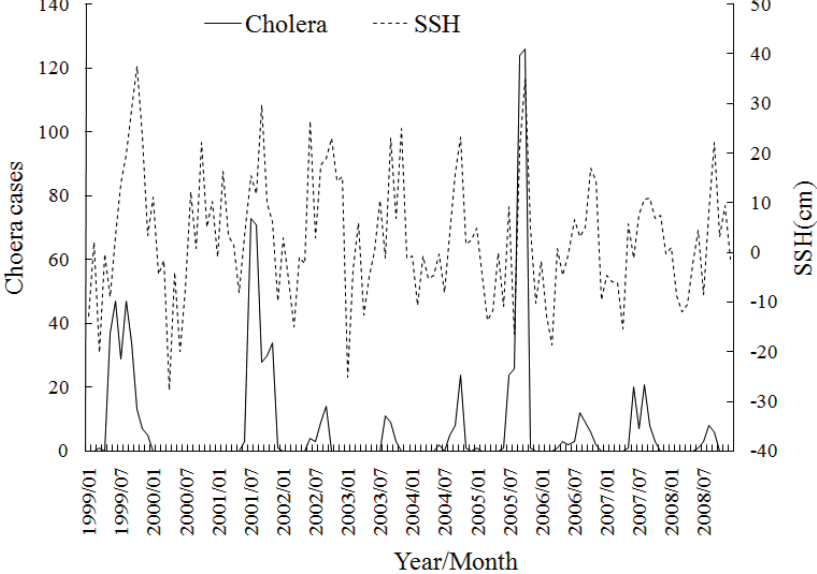
Figure 5. Time series of monthly cholera cases and SSH in Zhejiang, China during